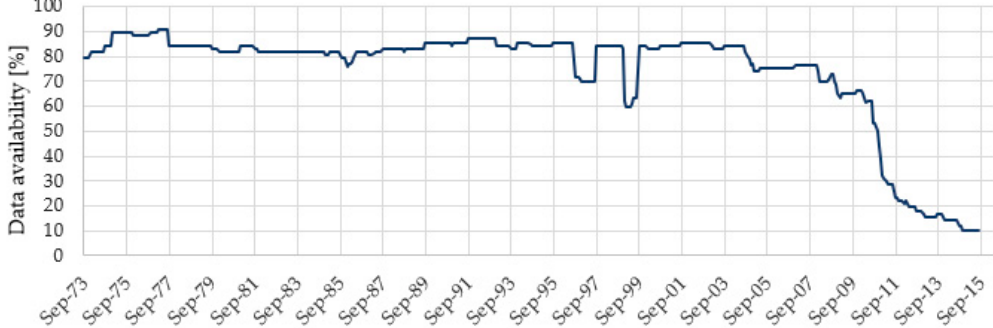
Figure 2. Data availability timeline between 1 September 1973 and 31 August 2015.